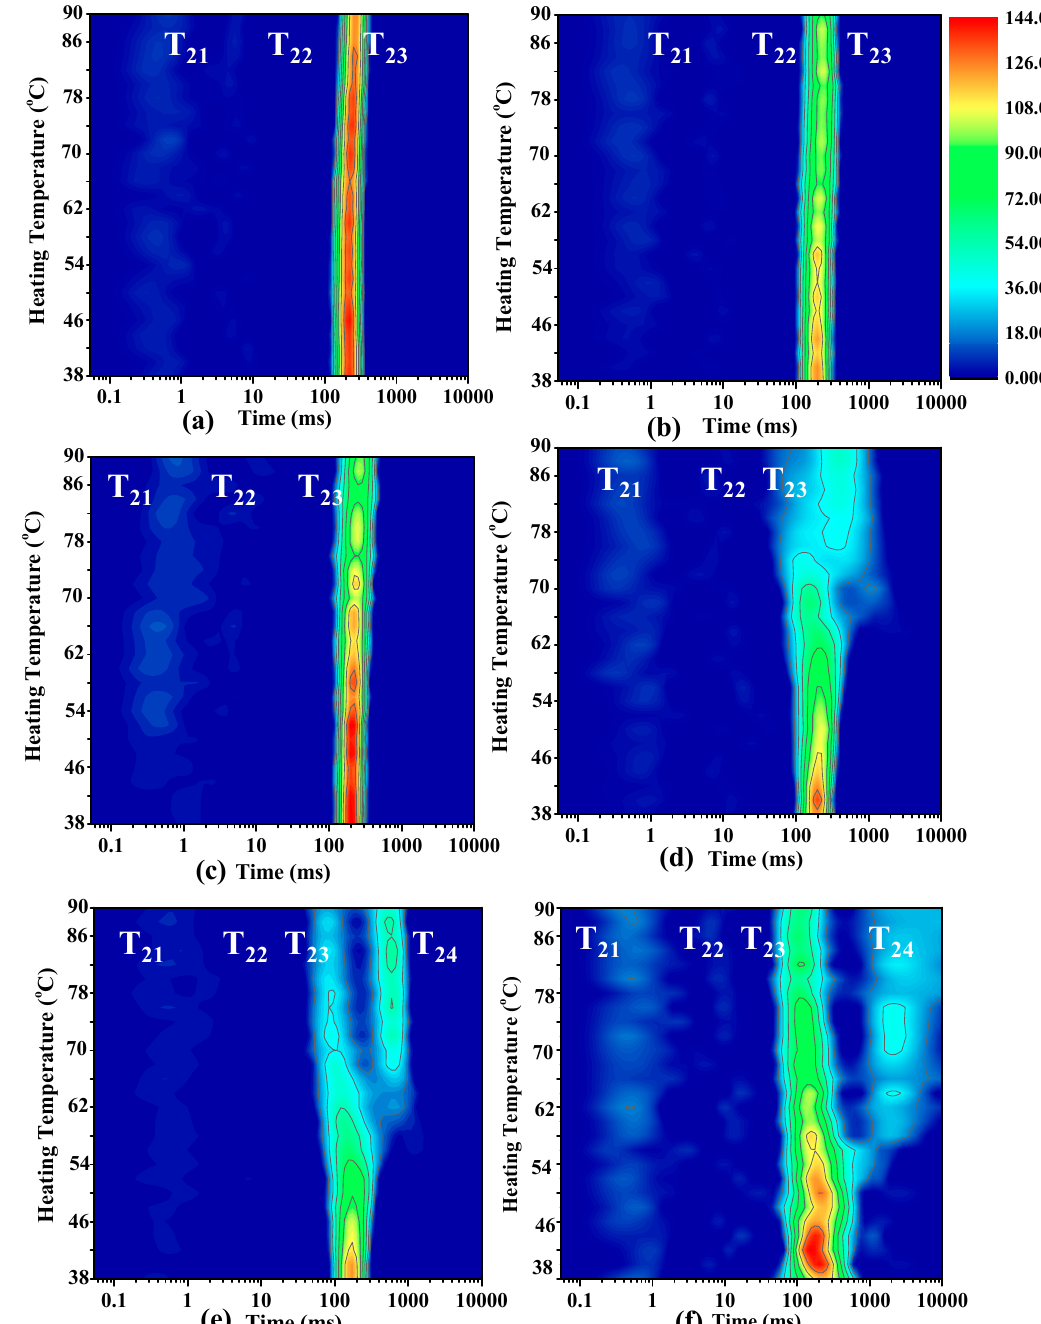
Figure 1. Plots of T 2 relaxation times for the SP and MP system during heating from 38 to 90 ◦ C with SP: MP ratio at 10:0 ( a ); 8:2 ( b ); 6:4 ( c ); 4:6 ( d ); 2:8 ( e ); and 0:10 ( f ). The initial protein content of SP and MP solution was 7.8% and 3.6%, respectively.